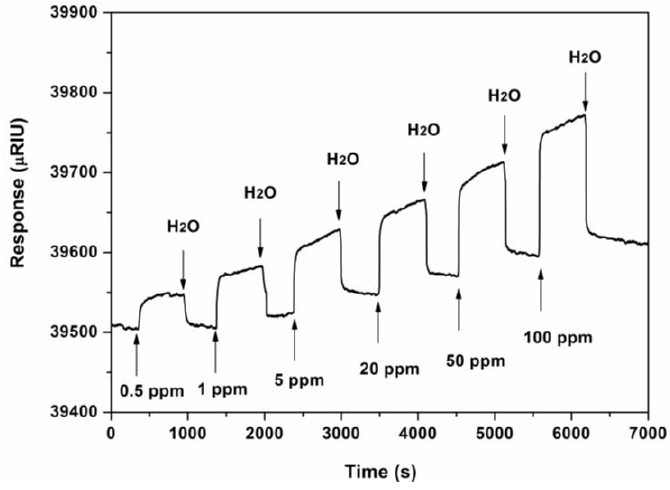
Figure 9. SPR response induced by the ZPCPI nanofibrous membrane deposited on an SPR chip when exposed to pyridine solution with different concentrations. H buffer solution throughout the whole